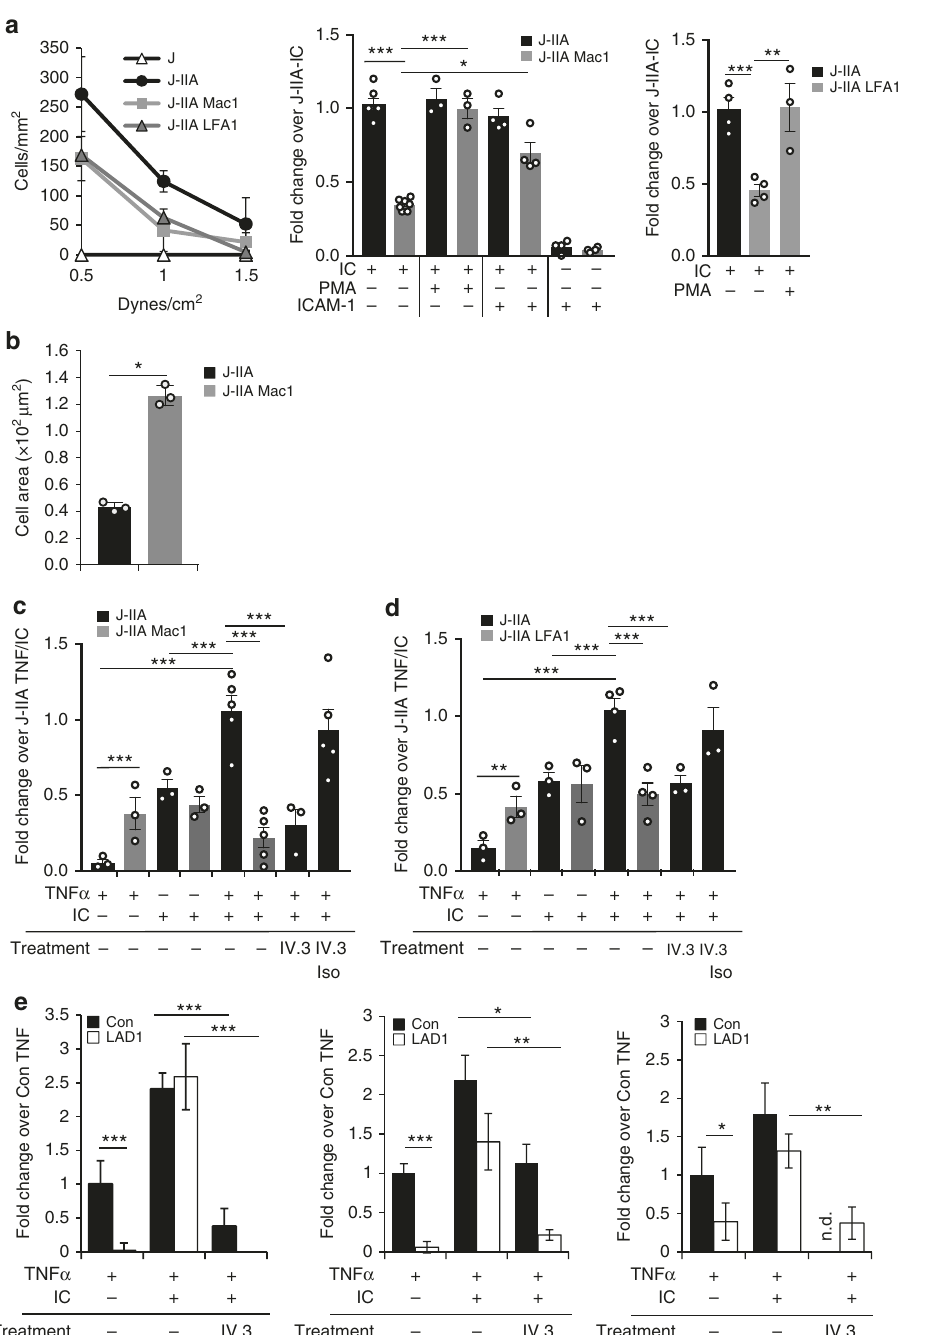
Fig. 1 CD18 integrins, Mac-1 and LFA-1 in cis inhibit Fc γ RIIA mediated interaction with ICs under fl ow. Cells were perfused under physiological fl ow conditions over plate immobilized ICs ( a , b ) or TNF activated human dermal microvascular endothelial cells (HDMEC) with or without ICs generated by incubating cells with mouse anti-endoglin mAb (anti CD105) and rabbit anti-mouse IgG ( c , d ). The number of adherent cells was assessed and averaged. a Jurkat cells expressing Fc γ RIIA (J-IIA) with Mac-1 (J-IIA Mac1) or with LFA-1 (J-IIA LFA1) were perfused over immobilized ICs or ICs co-immobilized with ICAM with or without prior PMA treatment. Left panel shows cell adhesion to immobilized ICs at the indicated shear stress. Data is presented as average ± SD of one representative of four experiments with duplicate coverslips per condition. Right panel, bar graphs represent fold change compared to J-IIA cells at 1.0 dyne/cm 2 under indicated conditions. Data is presented as average ± SEM. b After perfusing cells over immobilized ICs, the coverslips were fi xed, permeabilized, and stained with rhodamine-phalloidin to visualize the actin cytoskeleton. Bar graphs represent cell area. Data is presented as average ± SEM of n = 3. c , d Indicated Jurkat cells were perfused over TNF α -activated HDMEC with or without deposited ICs. The number of adherent cells was assessed. No rolling was observed. Cells were pre-treated where indicated with anti-Fc γ RIIA (IV.3) or isotype controls for 30 min at 37 °C. Bar graphs represent fold change compared to J-IIA TNF/IC. Data is presented as average ± SEM of n = 3 – 5. e Isolated human peripheral blood PMNs from 3 normal donors (control) and 3 LAD1 patients were pre-treated where indicated with anti-Fc γ RIIA (IV.3) and perfused across TNF α activated HDMEC with or without IC coating and analyzed as in c . Results for each of the three LAD1 patients with 15.3, 17.9, and 22.7% CD18 compared to their respective healthy donors (Con) is shown. Data is average fold change compared to TNF alone control ± SD from duplicate coverslips. For a , b * p < 0.05; *** p < 0.001 using the Student ’ s unpaired t -test. For c – e * p < 0.05; *** p < 0.001 using the one way ANOVA followed by Sidak ’ s Multiple comparison